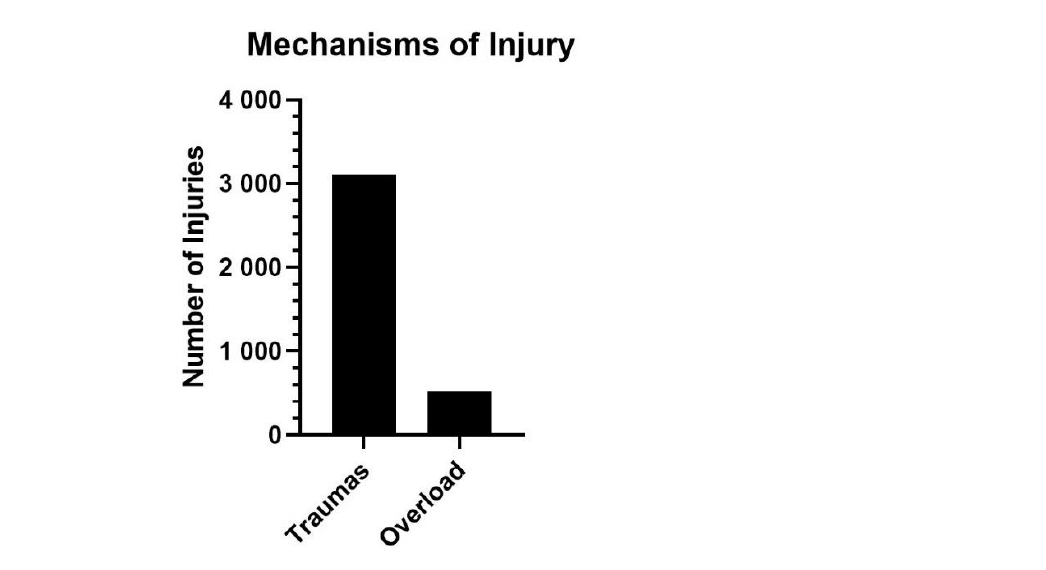
Figure 3. Production mechanism of lower limb injuries among handball players.